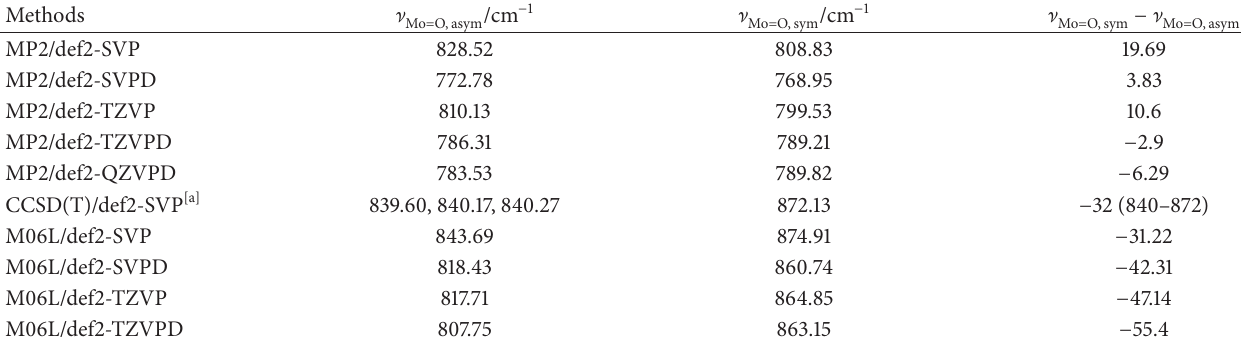
Table 8: Results of asymmetric and symmetric Mo=O stretches for MoO 4 2 − at various levels of theory. See Figure 5.